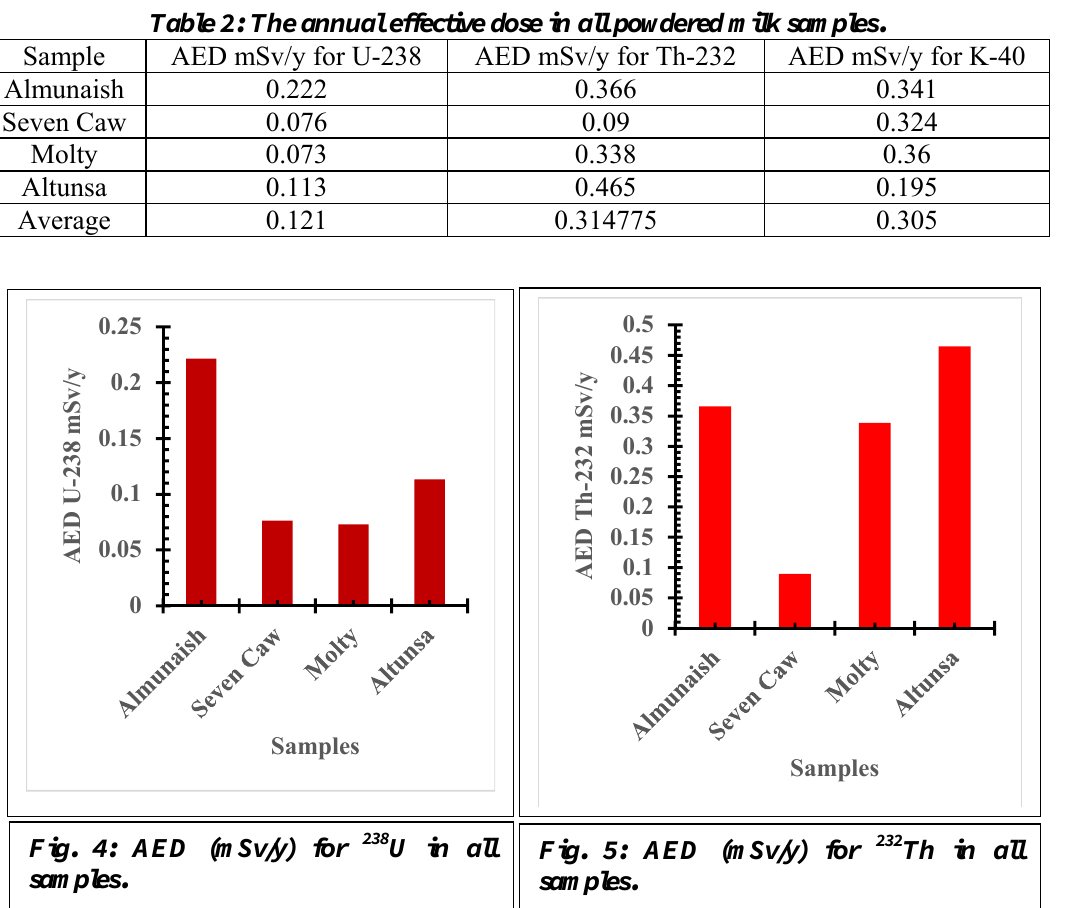
Fig. 4: AED (mSv/y) for 238 U in all samples.